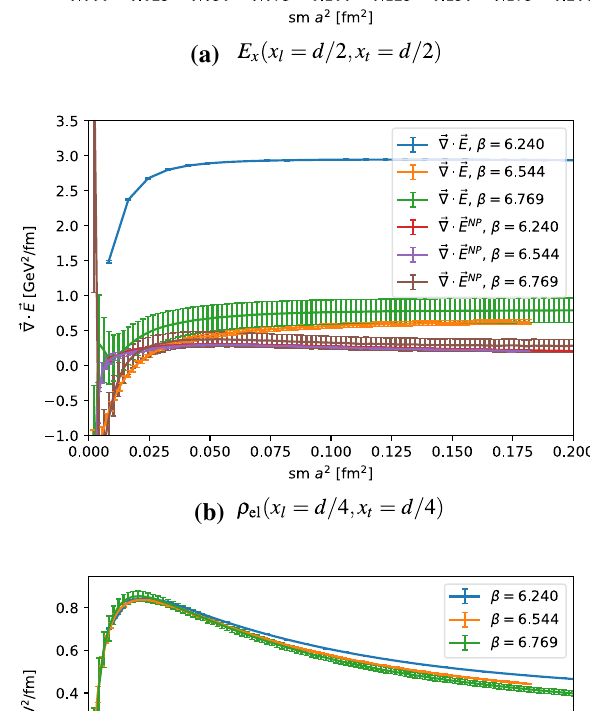
= d / 4 is plotted for l